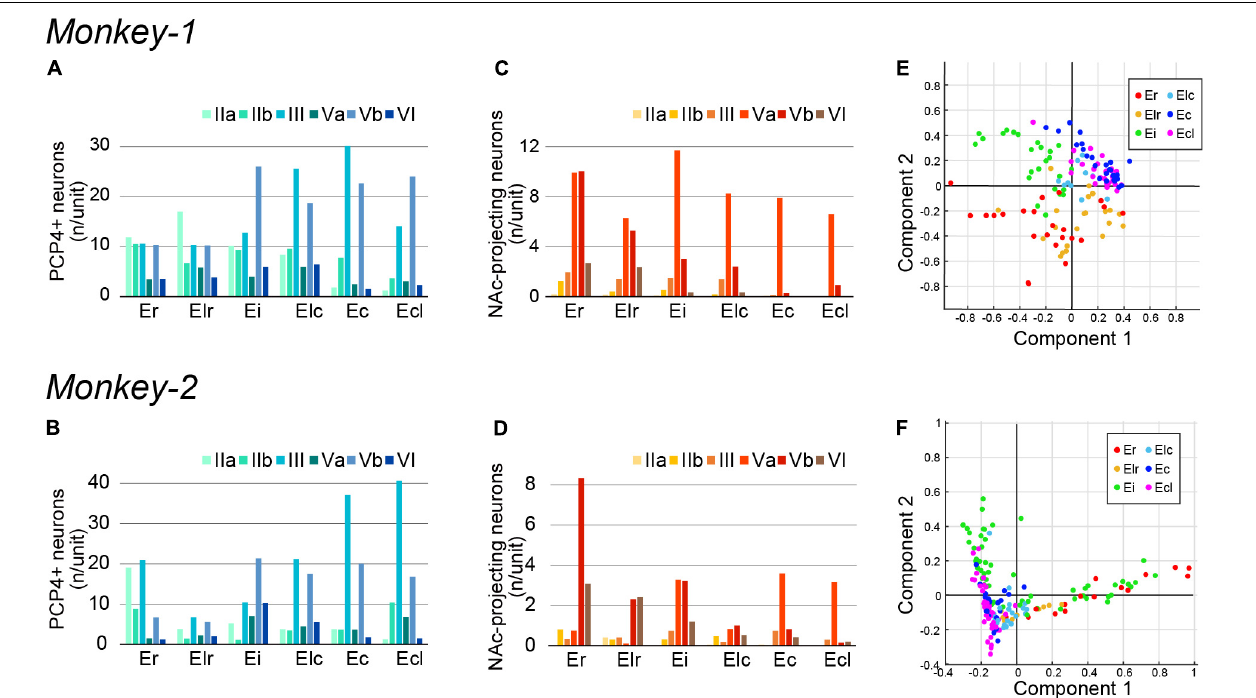
FIGURE 3 | Quantification of PCP4 + neurons and NAc-projecting neurons in monkey EC. (A–D) A diagram showing the number/unit of PCP4 + neurons (A,B) and NAc-projecting neurons (C,D) in each EC subdivision across layers in Monkey-1 (A,C) and Monkey-2 (B,D) . (E,F) Principal component analysis based on the parameters show in (A–D) (see section “Materials and Methods” for detail). (E) The two principal components explaining most of the variance in case of Monkey-1, with the combined information of NAc-projecting neurons in layer Va/Vb contributing most. (F) The two principal components explaining most of the variance in case of Monkey-2, with component 1 mainly representing the number of NAc-projecting neurons in layer Vb whereas component 2 mainly represents the number of NAc-projecting neurons in layer